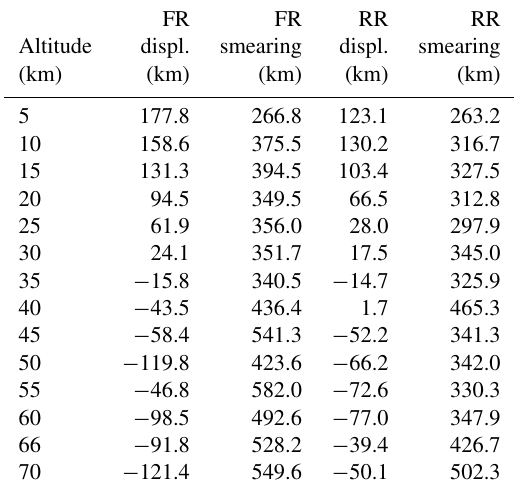
Table 3. Horizontal information distribution for FR and RR.